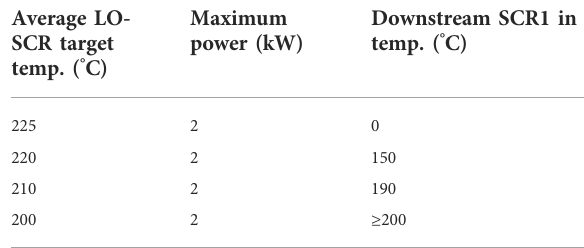
TABLE 6 Control strategy for the E-heater component in the EHM system for LLC and beverage drive